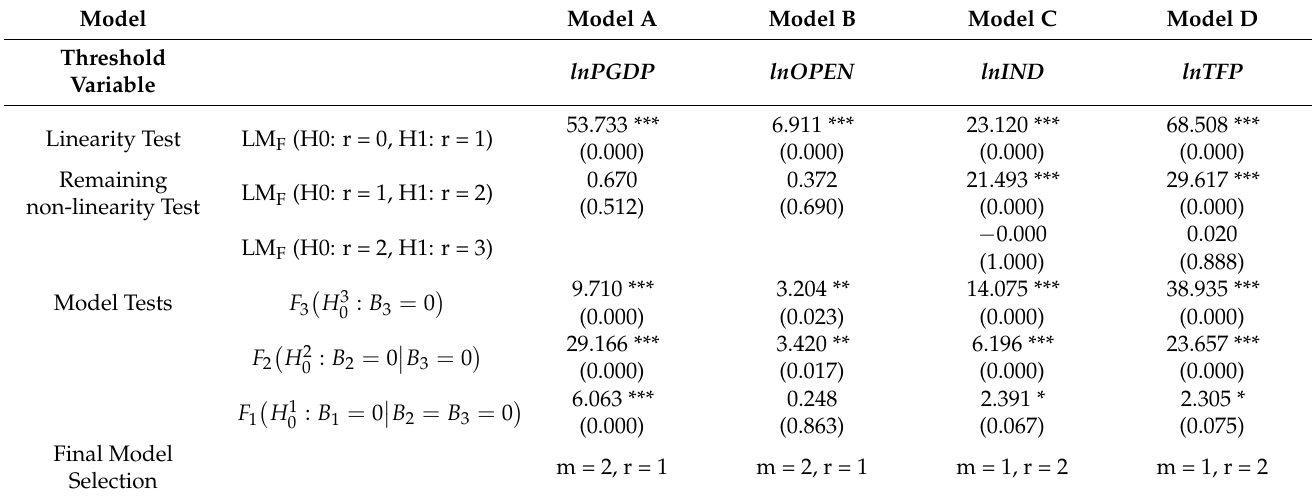
Table 3. Linearity and remaining non-linearity